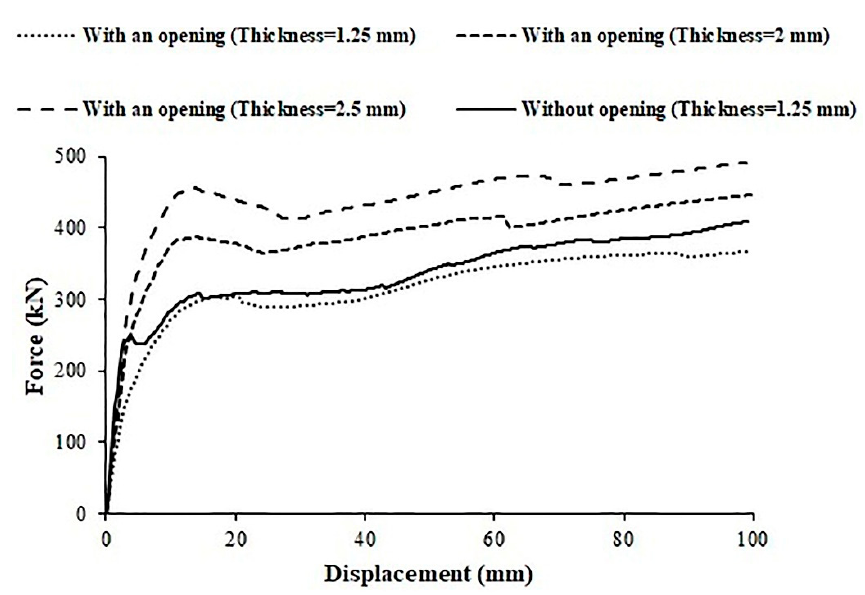
Figure 24. Force-displacement curves of four corrugated steel infill panels.